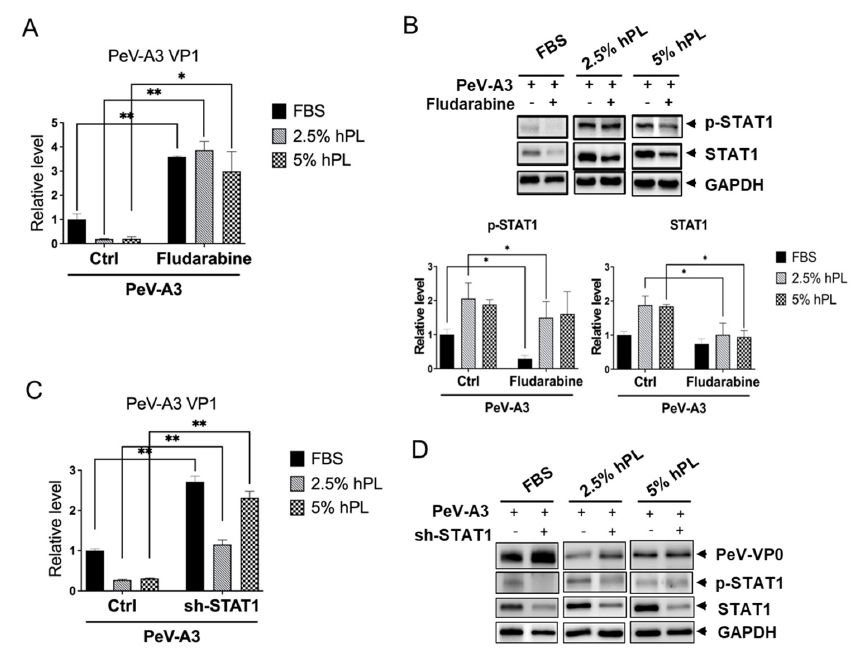
Figure 6. Enhanced PeV-A3 VP1 gene expression under blockade of STAT1 on PeV-A3 infection of GBM cells. ( A ) GBM cells were pre-treated with fludarabine 50 μ M for 30 min under FBS or hPL medium. After treatment, GBM cells were then infected with PeV-A3 at MOI = 1 for 6 h. Expression of PeV-A3 VP1 genes was measured using real-time qPCR. The level of PeV-A3 VP1 was normalized to GAPDH. Data are mean ± SD of three independent samples. Student’s t -test, *, p < 0.05; **, p < 0.01 compared with PeV-A3-infected GBM cells under FBS or hPL mediums. ( B ) GBM cells were pre-treated with fludarabine 50 μ M for 30 min under FBS or hPL mediums. After treatment, GBM cells were infected with PeV-A3 at MOI = 1 for 6 h. Cellular protein lysates were subjected to immunoblotting with anti-phospho-STAT1, anti-total-STAT1, and anti-GAPDH (upper panels). Quantification of protein expression levels of PeV-VP0, total-STAT1, and phospho-STAT1 was normalized to GAPDH. Data are mean ± SD of three independent experiments. Student’s t -test, *, p < 0.05 (lower panels). ( C ) The STAT-1 was knockdown by shRNA transfection; the cells were then infected by PeV-A3 at MOI = 1 for 48 h. The expression level of PeV-A3 VP1 RNA was measured by RT-qPCR. Data are mean ± SD of three independent samples. Student’s t -test, **, p < 0.01 compared with PeV-A3-infected GBM cells under FBS or hPL mediums. ( D ) The protein expression of PeV-A3 VP0, STAT1, phospho-STAT1, and GAPDH were detected by immunoblotting assay.